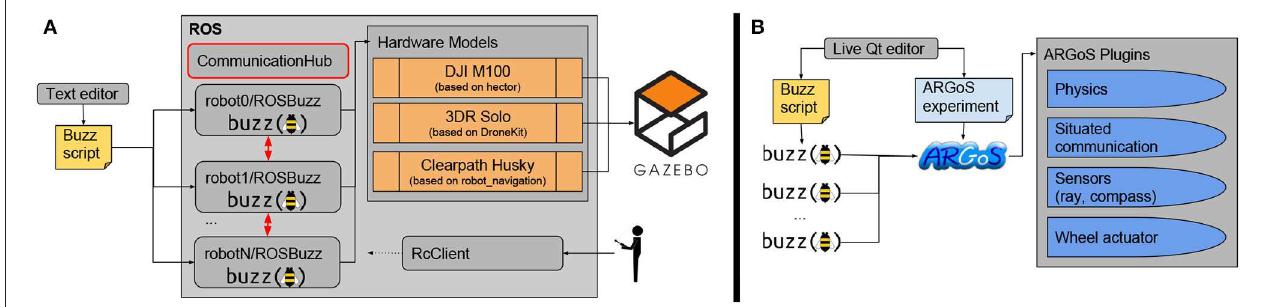
FIGURE 3 | Simulation environments: (A) with Gazebo and ROS nodes, allowing for accurate dynamics and operator inputs, and (B) with ARGoS to simulate large swarm size in a lightweight